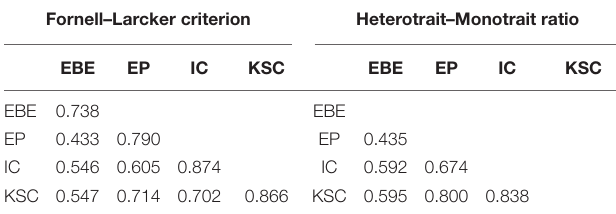
TABLE 2 | Measurement model assessment. TABLE 3 | Discriminant